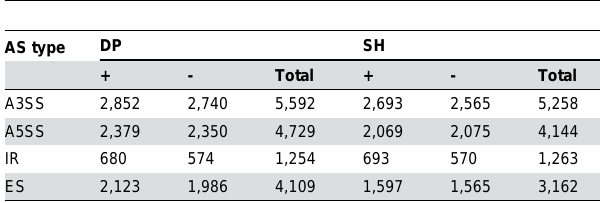
Table 5. Alternative splicing (AS) events and their distribution on the + and - strands of the reference genes.